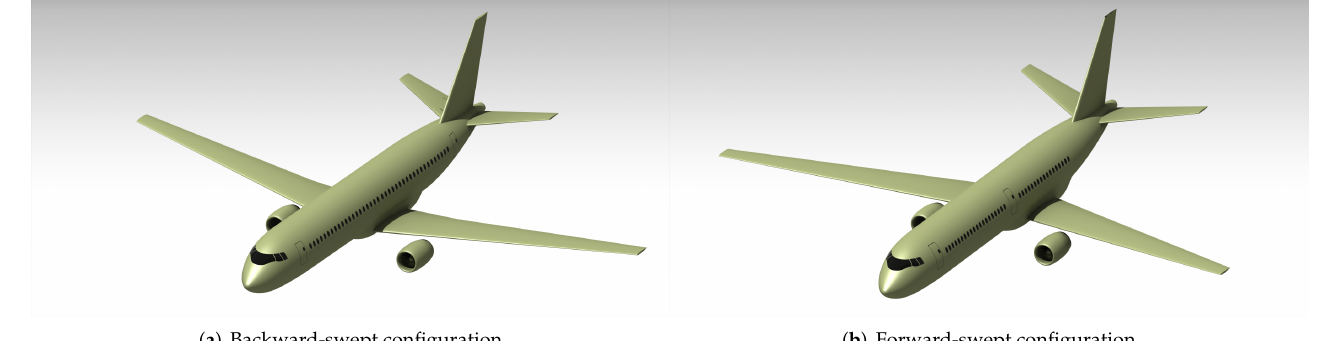
Figure 10. Aircraft configurations considered for the design study.